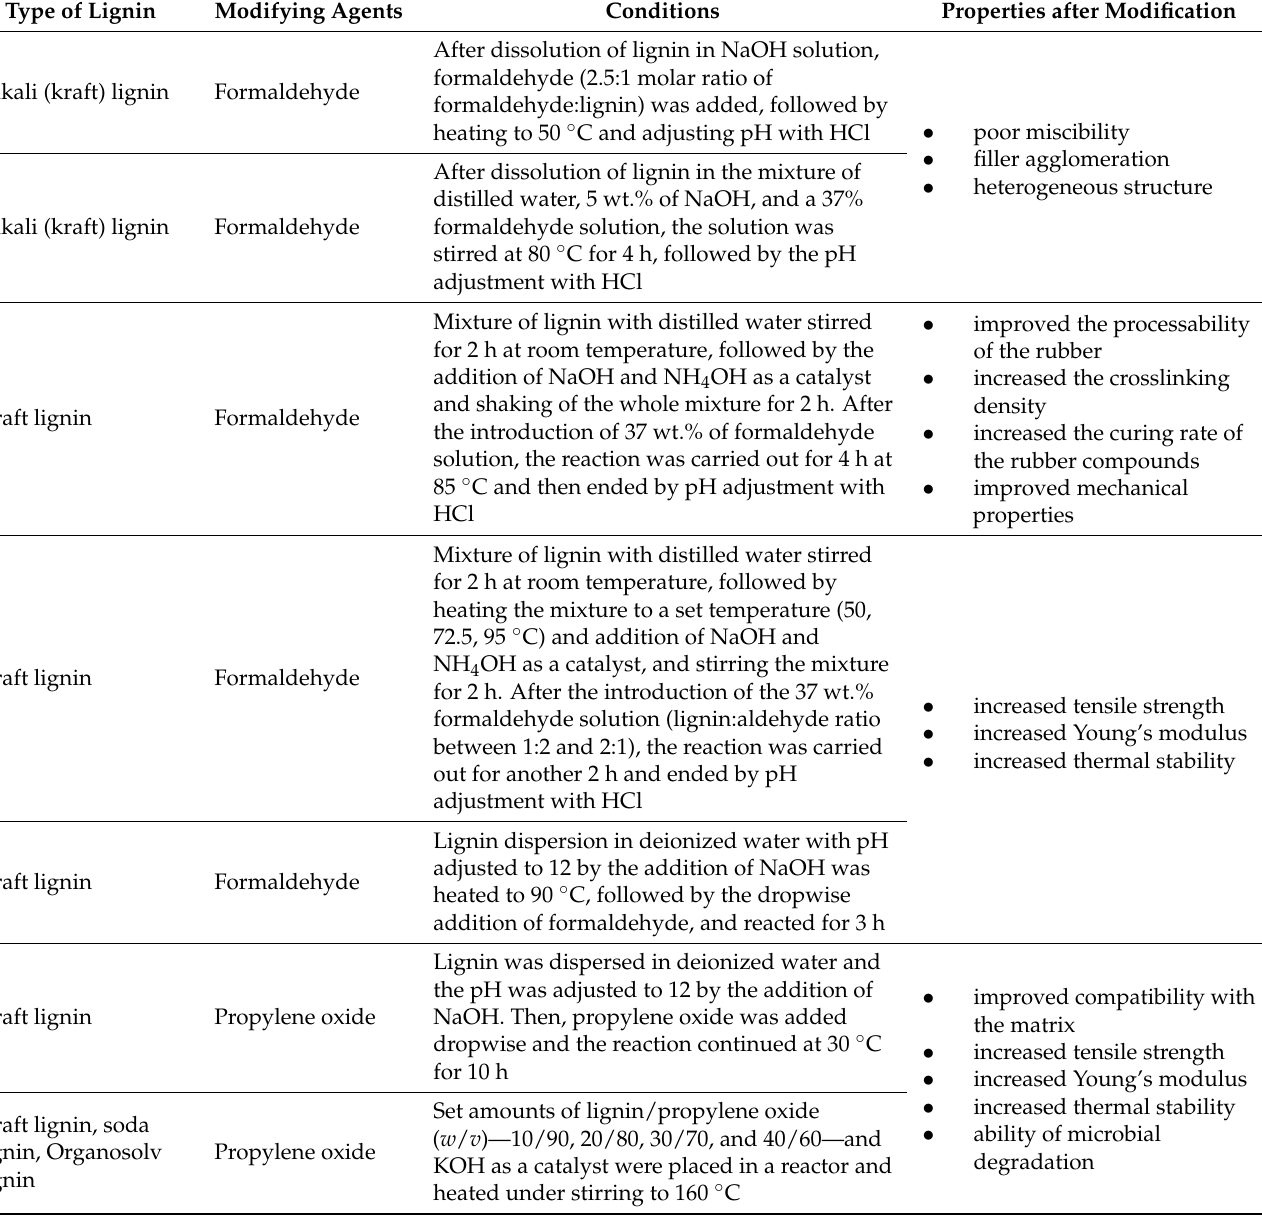
Table 8. Table summarizing the hydroxymethylation reaction of